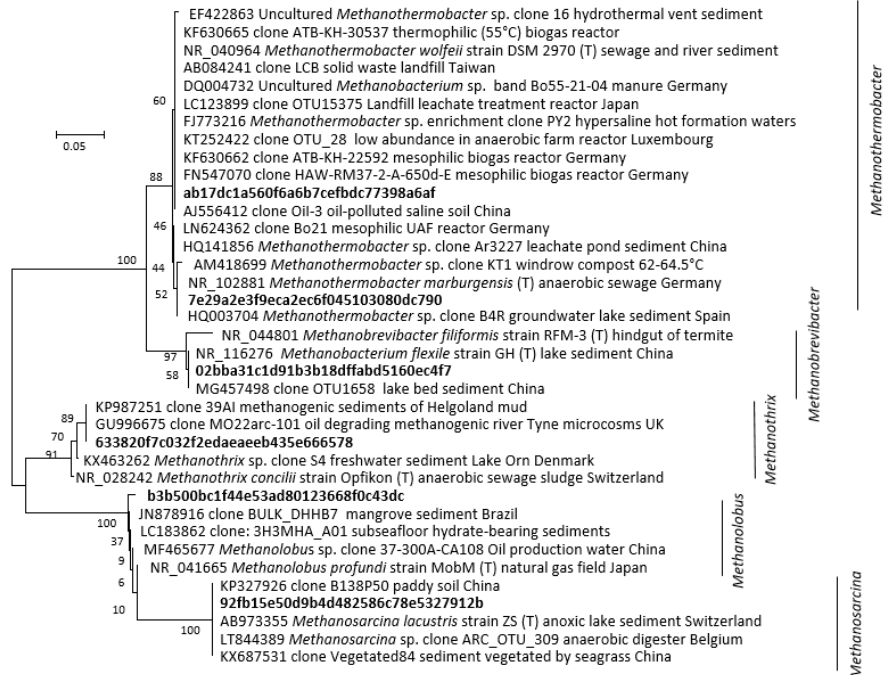
Figure 4. Phylogenetic distance tree (Neighbour-Joining) of key archaeal 16S rRNA amplicon sequence variants (ASVs) identified in the methanogenic microcosm and their close relatives. The tree was inferred from 248 positions. Individual codes for ASVs were assigned during pipeline analysis. The percentage of replicate trees in which the associated taxa clustered together in bootstrap analysis (1000 replicates) are shown next to the branches.